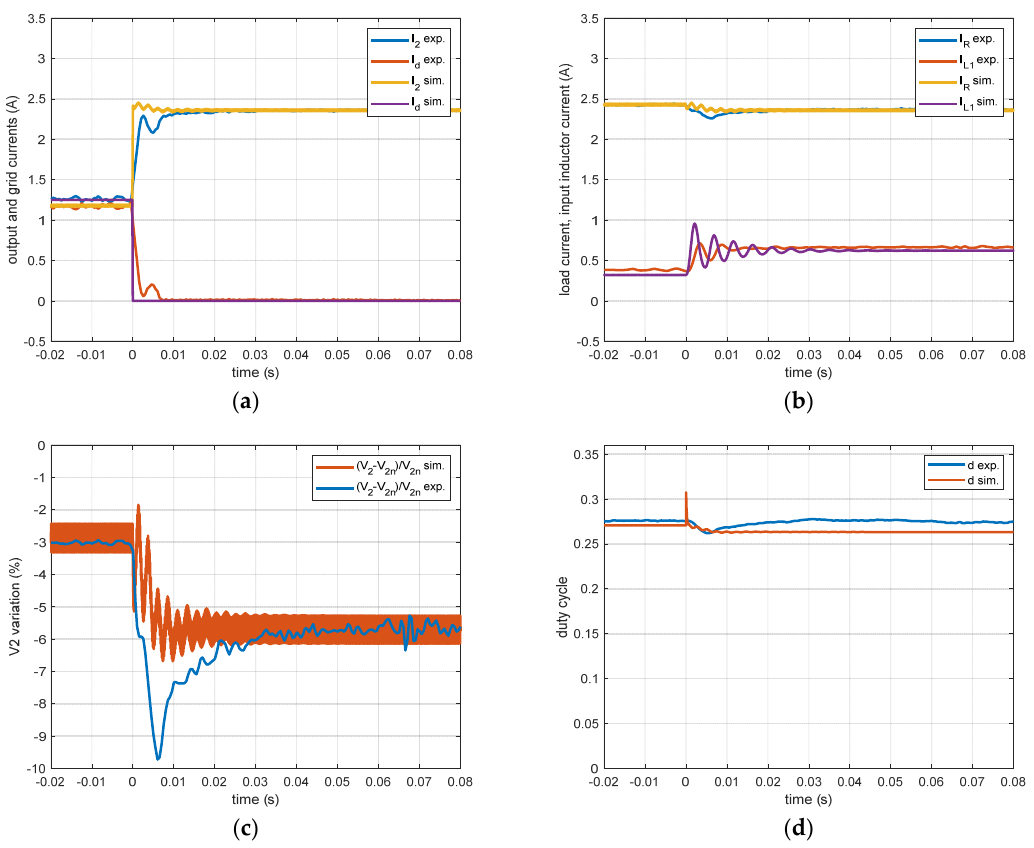
Figure 11. Simulation and experimental results in Scenario #2 (SD − GN): ( a ) output and grid currents; ( b ) load current and input inductor current; ( c ) grid voltage variation; ( d ) duty cycle.